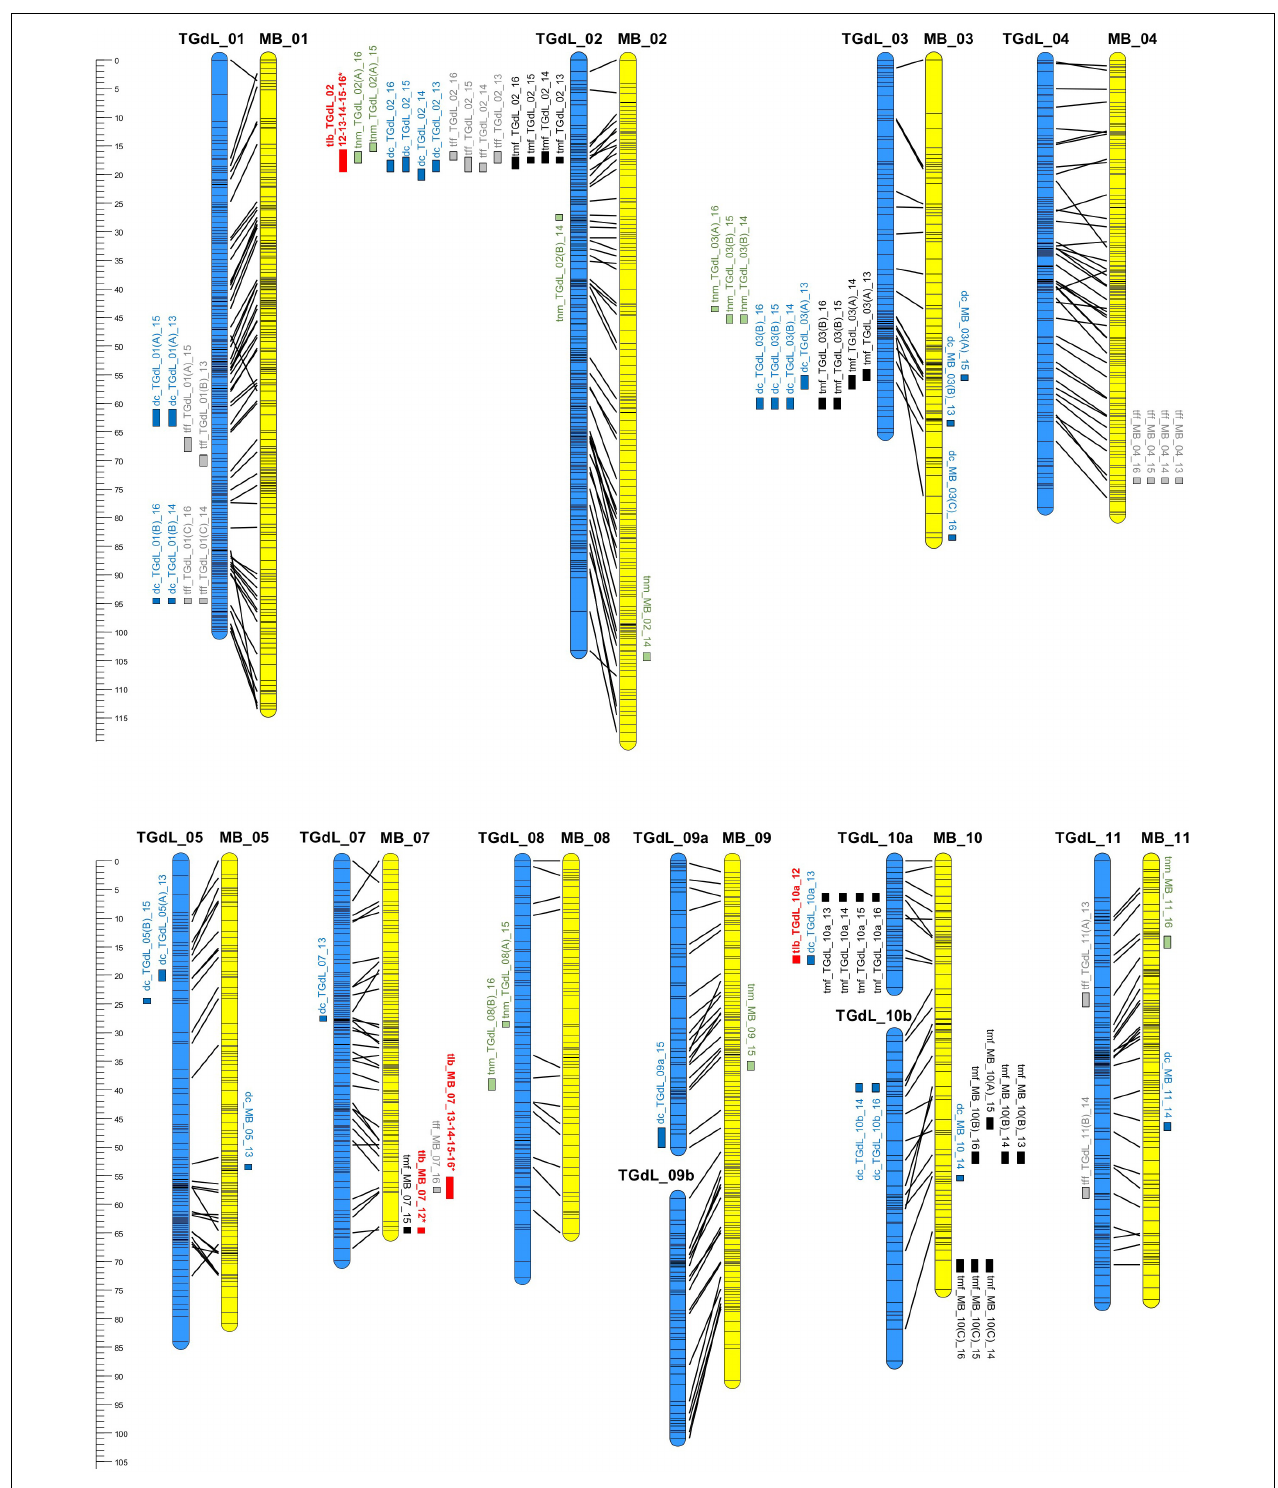
FIGURE 2 | Linkage maps derived from TGdL (female parent of the mapping population) and MB (male parent). TGdL LGs are shown in blue on the left and MB ones in yellow on the right. The maps have been aligned based on shared scaffolds. The locations of the tlb QTL are shown in red. LGs not harboring any QTL have not been included. The ruler on the left represents the physical length of the LGs, while QTL locations are indicated in cM.